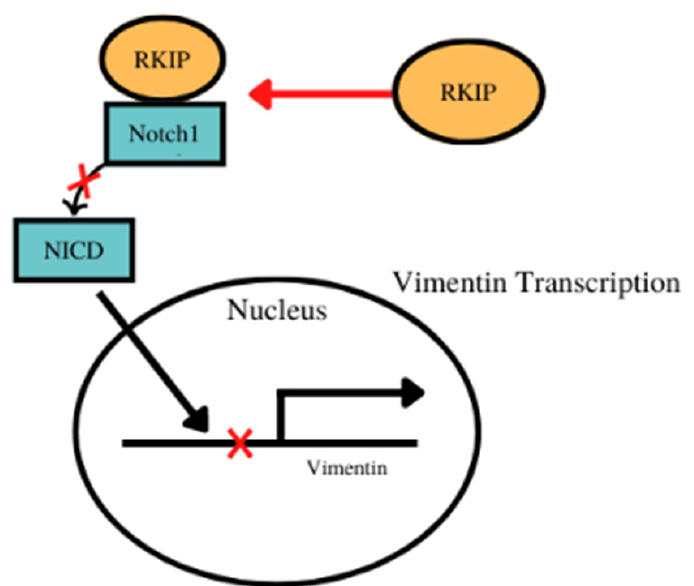
Figure 2. Crosstalk Between RKIP and Vimentin. RKIP binds to Notch1, blocking the cleavage of NICD. NICD is then unable to locate to the nucleus to induce the transcription of vimentin. RKIP is able to regulate the transcription of vimentin through interaction with Notch1.